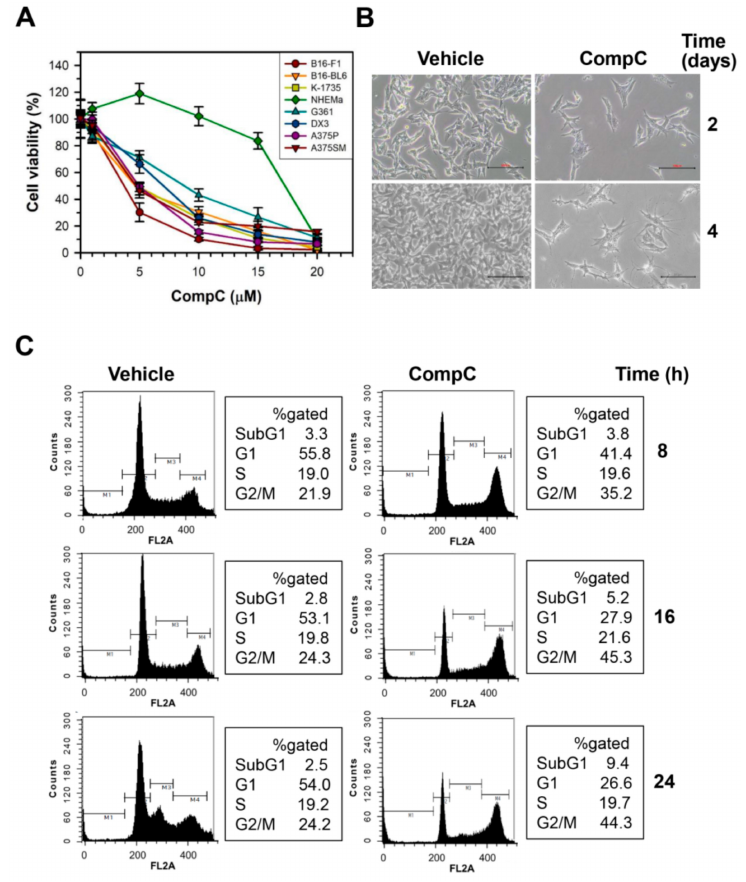
Figure 1. Compound C (CompC)-induced G2 / M cell cycle arrest in B16-F1 melanoma cells. ( A ) B16-F1, B16-BL6, K-1735, G361, DX3, A375P, A375SM, and NHEMa cells were cultured for 1 day and treated with vehicle (DMSO) or 1–20 µ M CompC for 2 days. An MTT assay was performed and the percentage of cell viability is plotted as the mean ± SD. ( B ) B16-F1 cells were treated with vehicle or 10 µ M CompC for the indicated times. The cell morphology was observed by optical microscopy (100 × ). ( C ) The cells treated with vehicle or 10 µ M CompC for the indicated times were stained with propidium iodide, and the DNA content was analyzed by flow cytometry. The percentage of gated area is shown on the